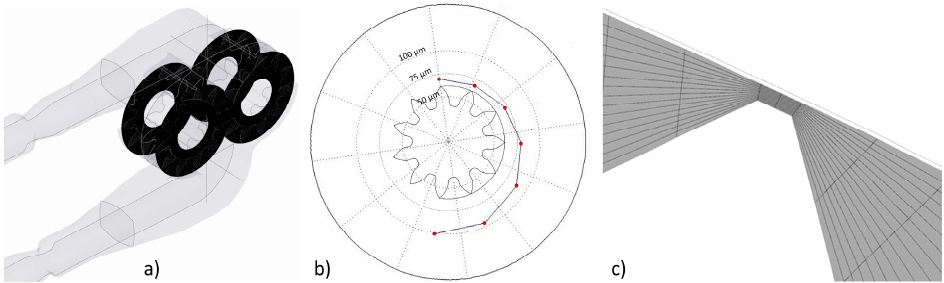
Figure 5. Particular domain discretization in correspondence of the gaps: ( a ) between the tooth flank and pump casing, ( b ) between the tooth head and the pump casing as a function of the angular position, and ( c ) computational mesh in the tooth head-case gap.